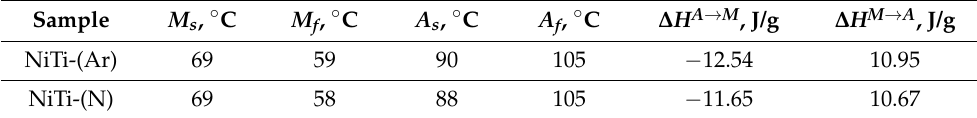
Figure 12. Temperature dependencies of accumulation and recovery of deformation during SME of porous TiNi-(Ar) and TiNi-(N) alloys. Table 2. DSC transformation temperatures and enthalpies of porous NiTi–(Ar) and NiTi–(N) samples.